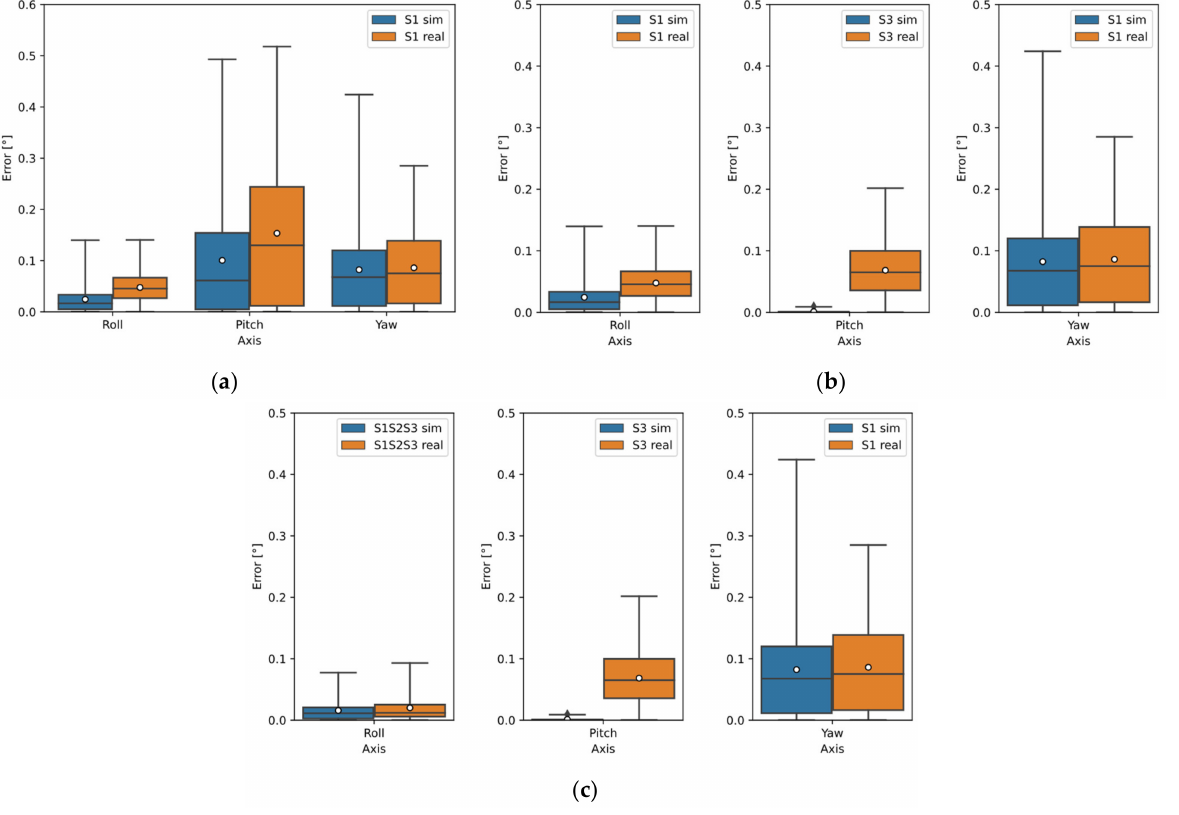
Figure 10. Comparison of results from simulation and real measurements of Object A: ( a ) using one sensor—S1; ( b ) configuration of two sensors: S1 and S3-S1 (Roll and Yaw detection) and S3 (Pitch detection); ( c ) configuration of three sensors—S1S2S3 (Roll detection), S3 (Pitch detection) and S1 (Yaw